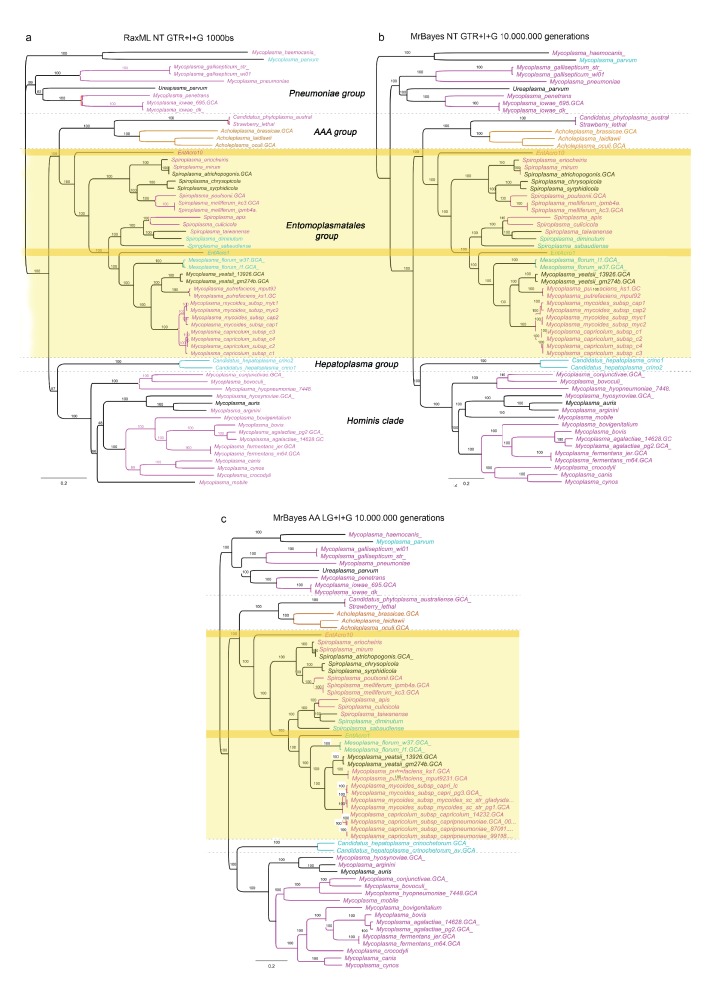
Alternative unrooted phylogenies based on the concatenated nucleotide and protein alignments of the 65 single-copy orthologs showing the phylogenetic relationships among 59 Mollicutes strains with sequenced genomes.(A) Maximum likelihood phylogeny constructed using the concatenated nucleotide alignment of the 65 single-copy orthologs, (B) Bayesian phylogeny using the concatenated nucleotide alignment, and (C) Bayesian phylogeny using the concatenated aminoacid alignment. Software, alignment type, type of model, and number of bootstraps or generations used in the analyses are given at the top of each phylogenetic tree. Bootstrap support is given for all genomes and the color-coded Latin species names refer to the different types of symbiotic associations found among Mollicutes and their hosts (Figure 1). Gray bold-faced text and dashed lines delineate clades and groups identified in a previous study (Leclercq et al., 2014). Both EntAcro strains are within the Entomoplasmatales group which has higher diversity of hosts, targeting vertebrates, invertebrates and plants, than any of the other groups where hosts appear to be more clade-specific. Related lineages to EntAcro10 (S. mirum and S. eriocheiris) and EntAcro1 (M. florum and M. yeatsii) are associated with taxonomically very different hosts than ants, suggesting that there have been no major constraints for radical host shifts among these Entomoplasmatales.